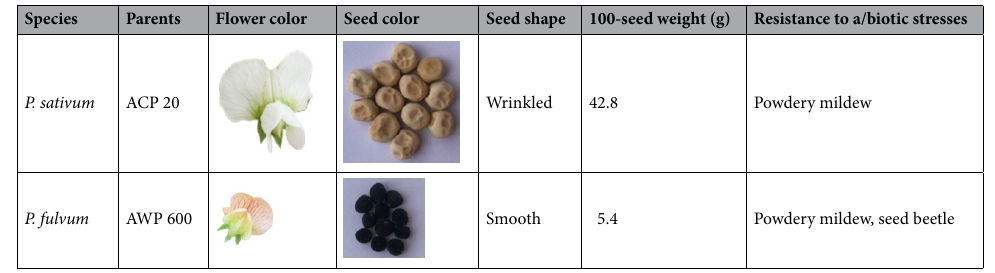
Table 1. Some agro-morphological and salient traits of parents used in interspecific crosses P. sativum × P.